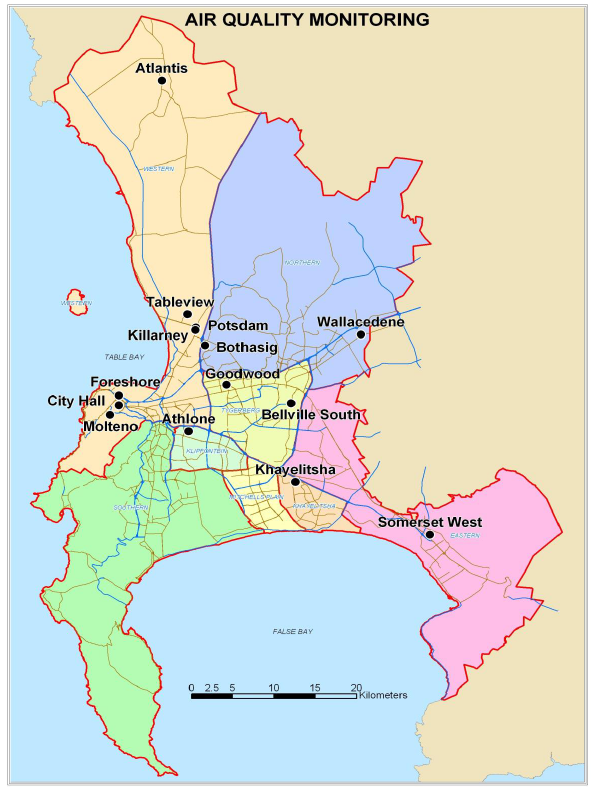
Figure 2: Map of the Cape Town, showing the air quality network in Cape Town and the location Fig. 2. Map of the Cape Town, showing the air quality network in of four observation stations (Bothasig, City Hall, Goodwood and Tableview) used in the study Cape Town and the location of four observation stations (Bothasig, (source: http://web1.capetown.gov.za/web1/cityairpol). The colour code indicates different City Hall, Goodwood and Tableview) used in the study (source: suburbs in the city. http://web1.capetown.gov.za/web1/cityairpol). The colour code in- dicates different suburbs in the